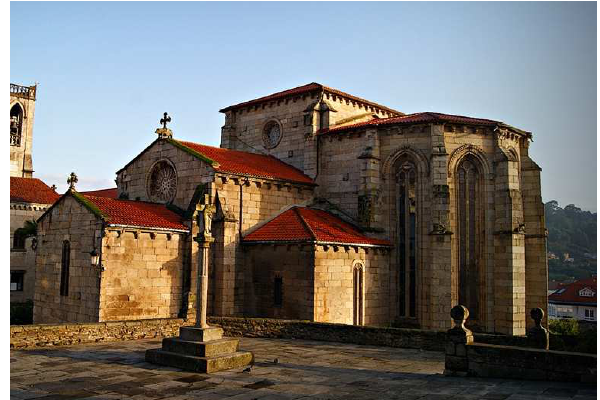
Figure 1. South view of San Francisco church.